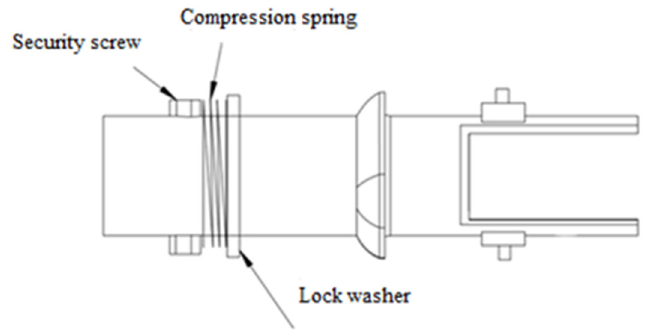
Figure 8. The second part of the shoulder joint.